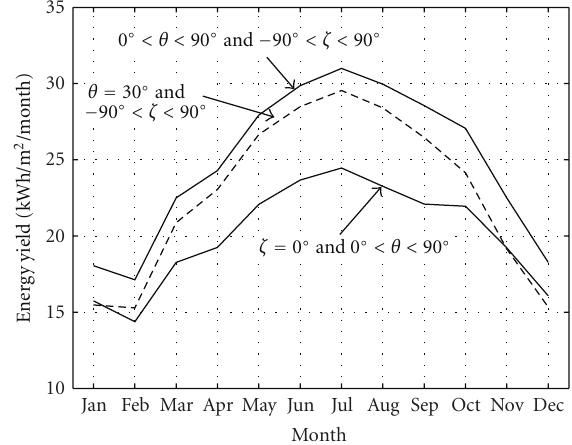
Figure 10: Comparison of the energy yield of the two-axis (variable θ and ζ ) and the one-axis (fixing ζ or θ ) tracking of PV systems. The tracking about azimuth or the inclination shows comparable results to each other in the winter